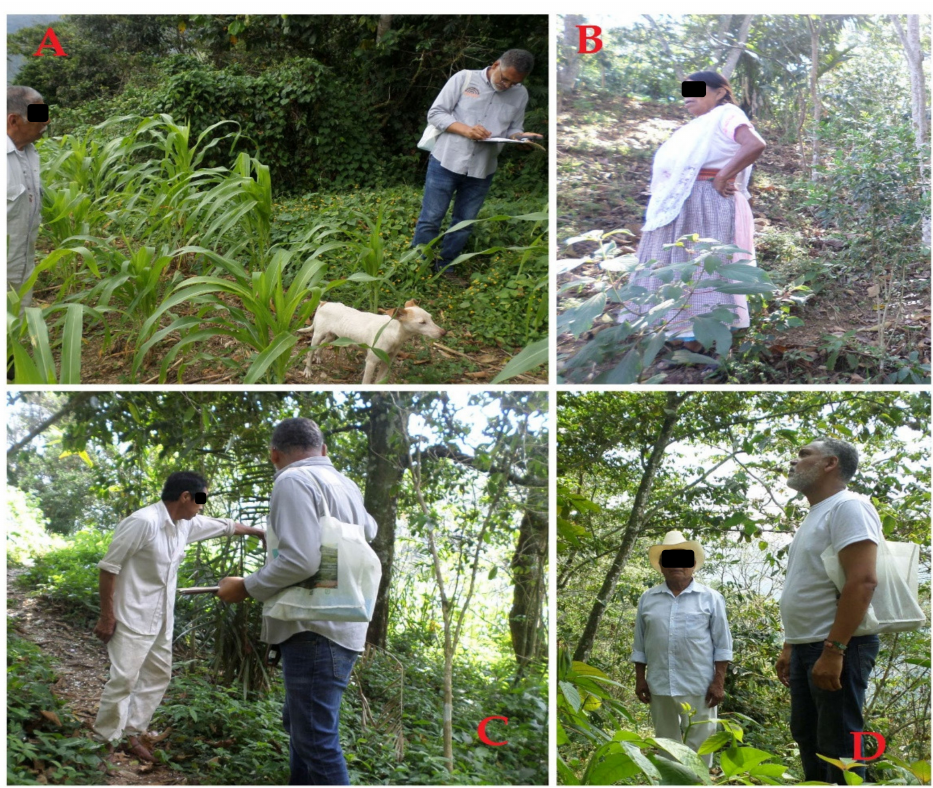
Figure 2. Interviews and participant observation in Huehuetla. ( A ) Community of Francisco I. Madero and ( B – D ) community of